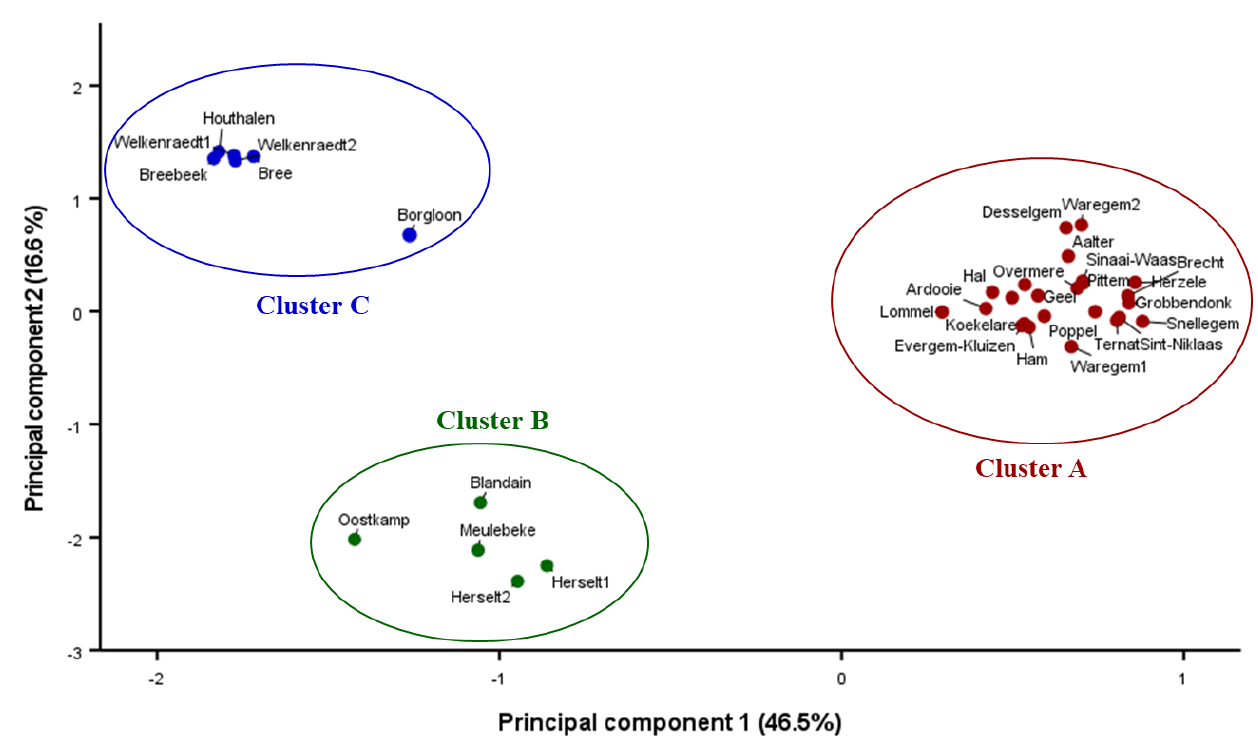
Figure 4. Graphical representation of the 35 C. esculentus clonal populations along the first and second principal component axis of the principal component analysis based on the genetic data from the AFLP analysis. The three genetic clusters A, B, and C are marked in red, green, and blue, respec- tively.